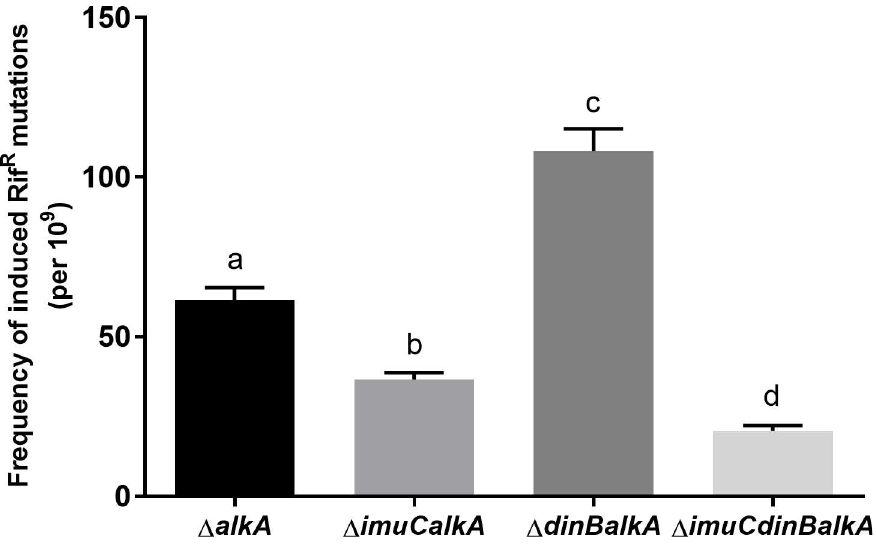
Fig 8. Effect of the ImuC and DinB deficiencies on the frequencies of MMS-induced Rif R mutations in P . aeruginosa alkA -deficient bacteria. Bacteriawere exposedto 0.15 mM MMS overnight. Data represents the mean ( ± SE). Groups that have no common letter are significantly different at P < 0.05, accordingto Kruskal-Wallis test followedby Dunn’smultiple comparisons